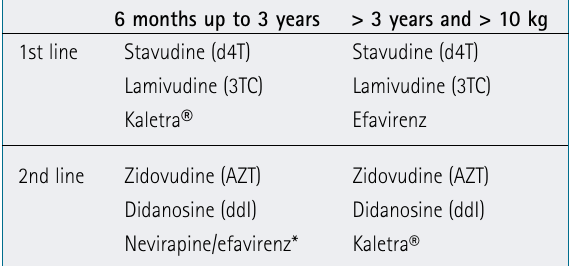
TABLE I. ANTIRETROVIRAL DRUG CHOICES FOR